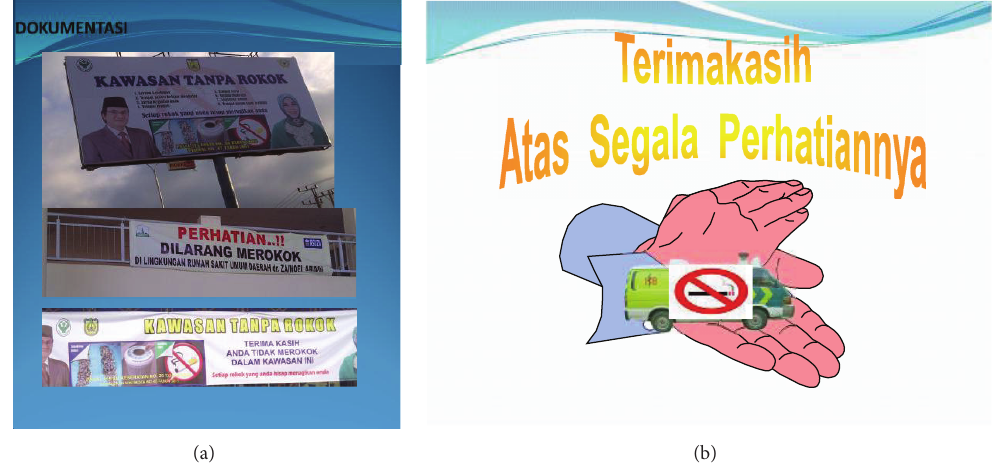
Figure 4: (a) Left above: example of freestanding “No Smoking Area” sign erected outside. Centre: example of No Smoking wall poster. Below: example of “No Smoking Area” wall sign. (b) Above: Thank You for Your Attention with no smoking sign used in slide